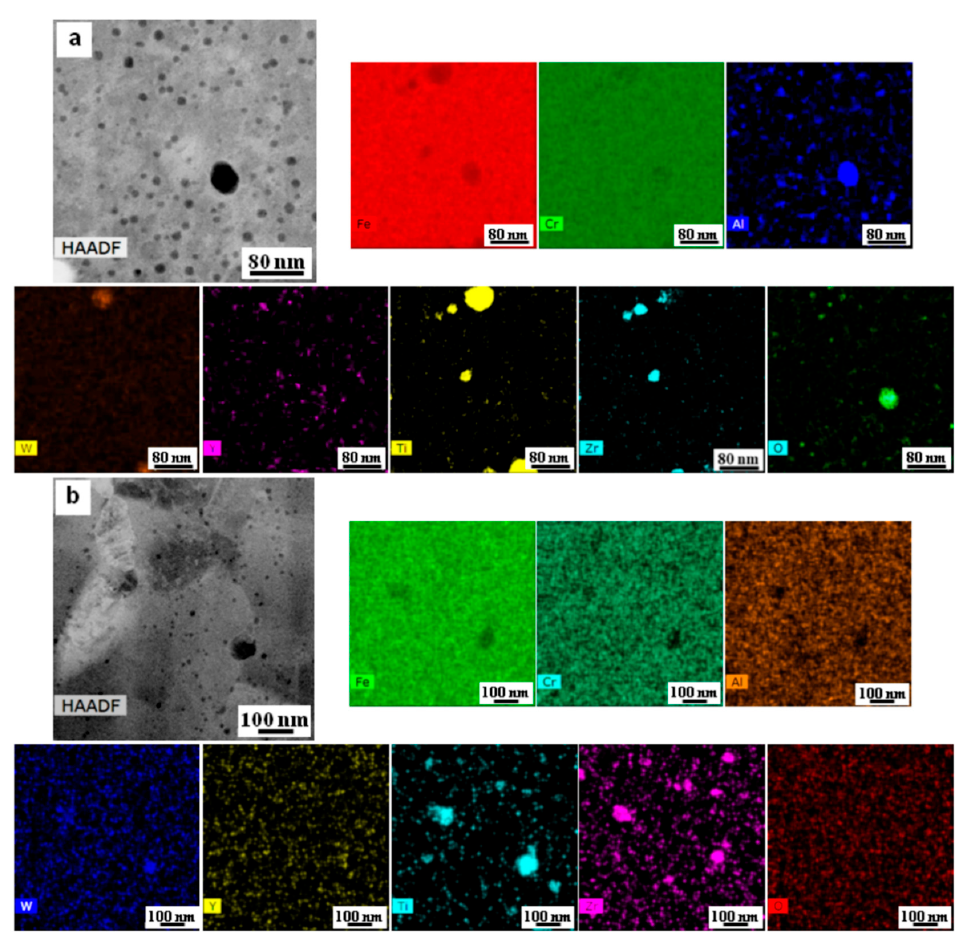
Figure 5. High angle annular dark field scanning transmission electron microscopy (HAADF-STEM) image and STEM-EDX elemental colour maps showing the oxides compositions in ( a ) ODS-0.45Zr, ( b ) ODS-0.60Zr .